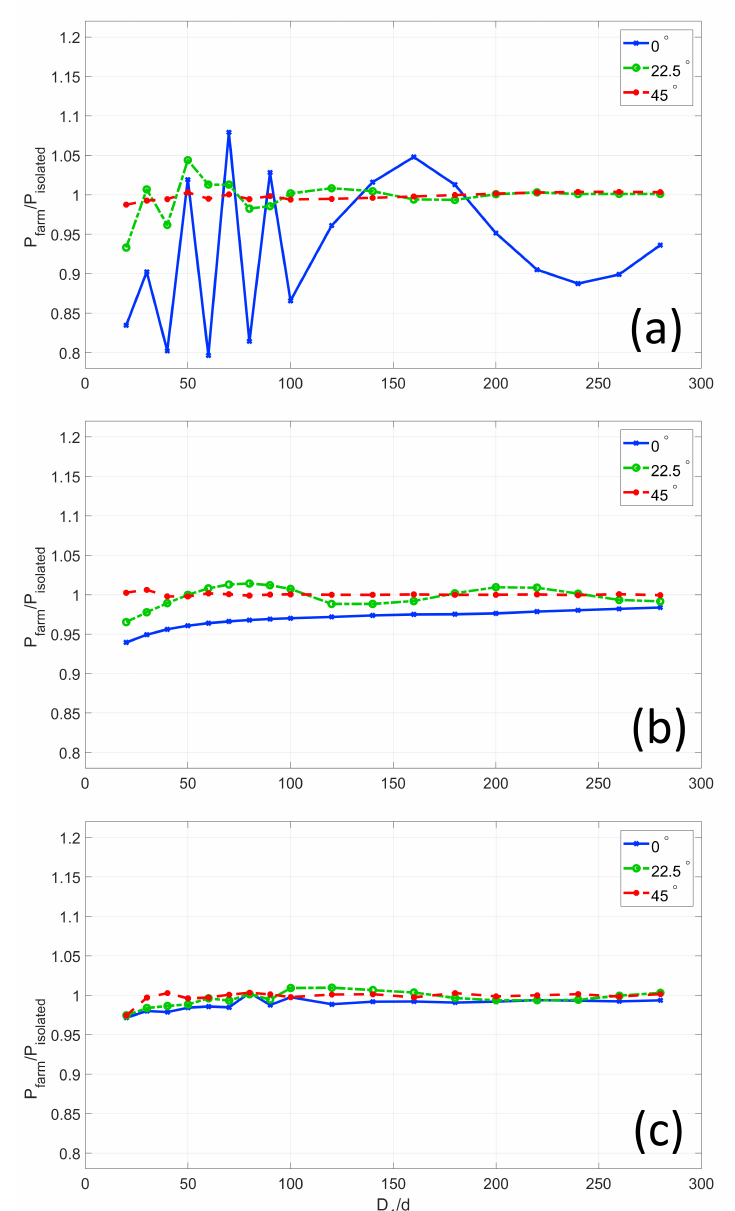
Figure 7. Ratio of P farm /P isolated for nondimensional distance D 1 / d , where d is the diameter of the WEC shown for regular waves of T = 6 s ( a ), T = 8 s ( b ), and T = 10 s ( c ) for β = 0 ◦ (solid line) 22.5 ◦ (dash-dot line), and 45 ◦ (dash